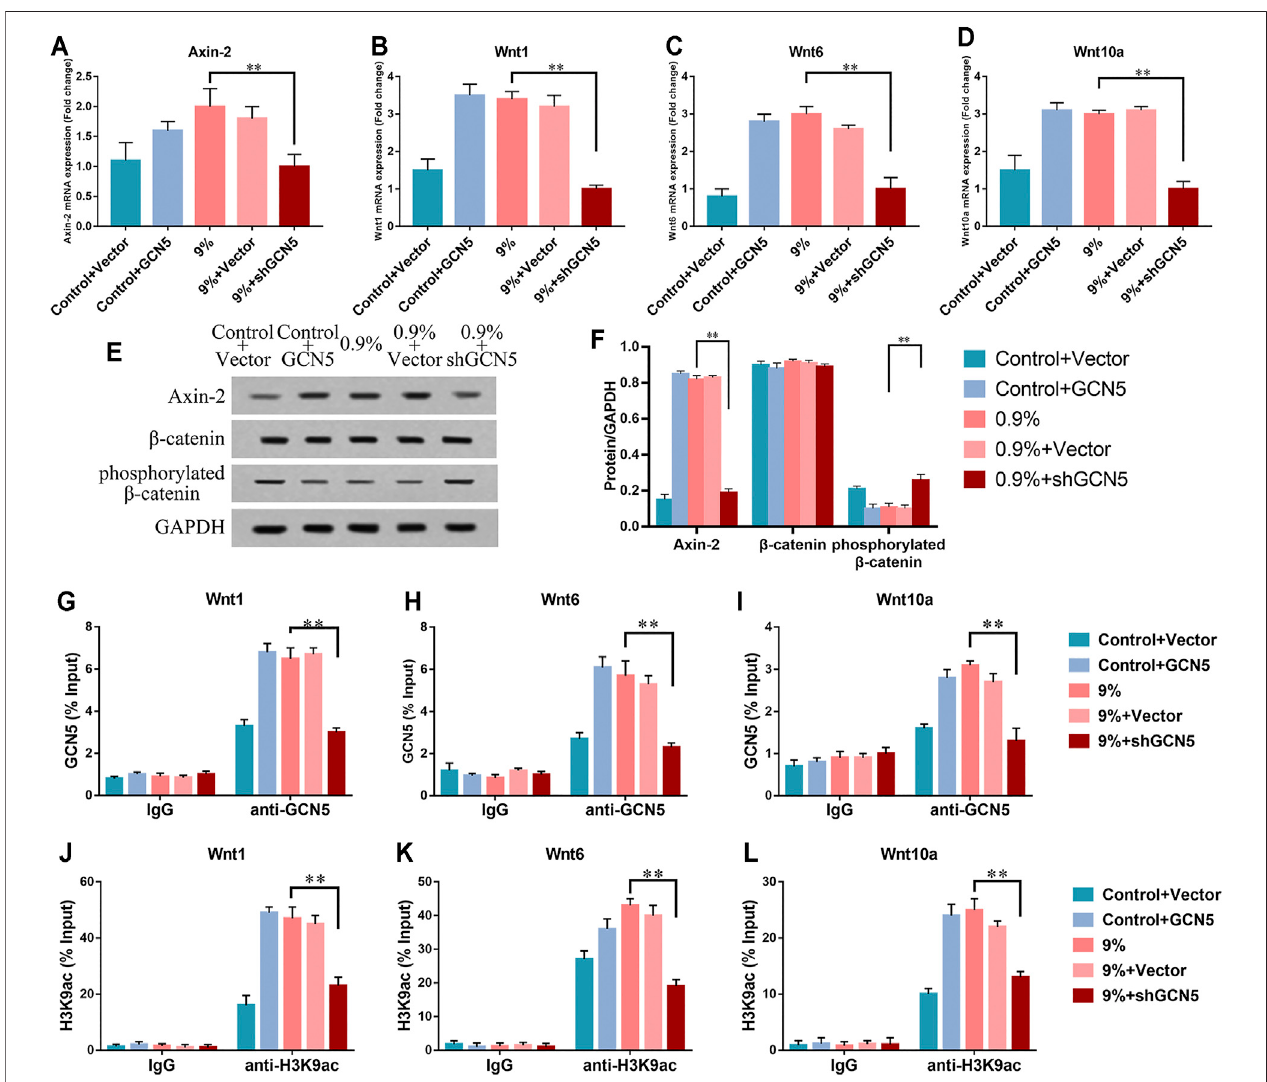
FIGURE6| TheactivityoftheWnt/ β -cateninsignalingpathwaywassuppressedbytheknockdownofGCN5. (A – D) mRNAexpressionofAxin-2,Wnt1,Wnt6,and Wnt10a in BMSCs transfected with overexpression of GCN5 in the control group or shRNA of GCN5 in the 0.9% group. (E) Western blots of Axin-2, phosphorylated β -catenin,and β -catenininBMSCstransfectedwithoverexpressionofGCN5inthecontrolgrouporshRNAofGCN5inthe0.9%group.GAPDHisshownastheloading control. (F) Semi-quantitative and statistical analyses of the results in Panel E. (G – I) The ChIP assay was performed to evaluate the combination of GCN5 to Wnt1, Wnt6,andWnt10a promoters aftertheknockdownofGCN5oroverexpressionofGCN5. (J – L) TheChIPassaywasperformedtoevaluatetheenrichmentofH3K9acto Wnt1, Wnt6, and Wnt10a promoter regions. Values are plotted as mean ± SD, * p < 0.05, ** p < 0.01.